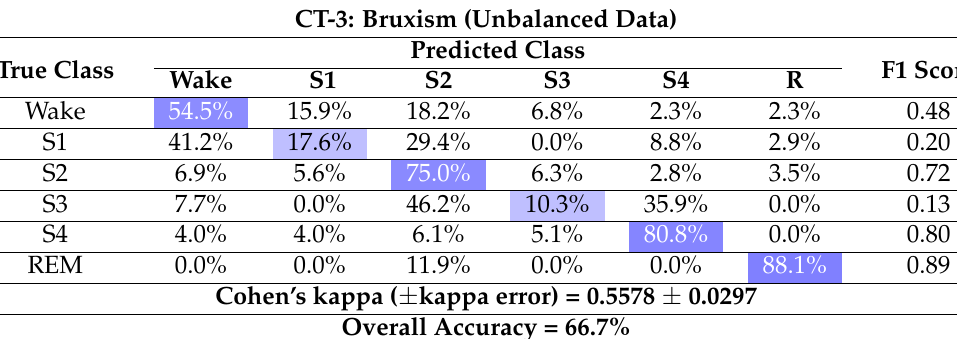
Table 13. Confusion matrix corresponding to sleep stage classification of bruxism patients with unbalanced data using the EBT classifier with 10-fold